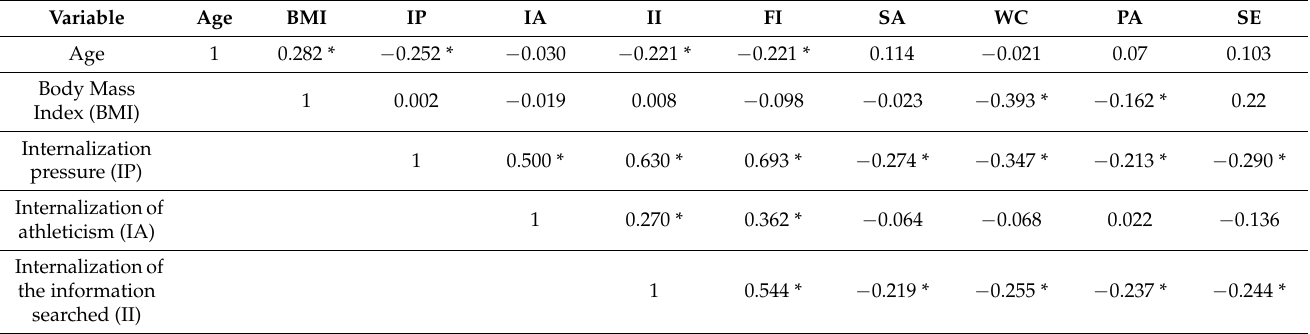
Table 2. Correlations between factors of social media use and selected lifestyle variables ( n =